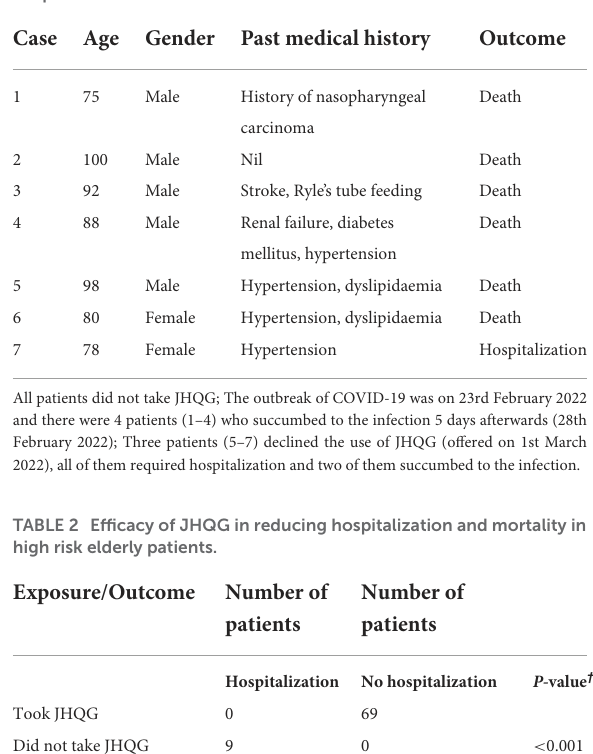
TABLE 1 Demographics and clinical data of patients progressing to hospitalization and death.